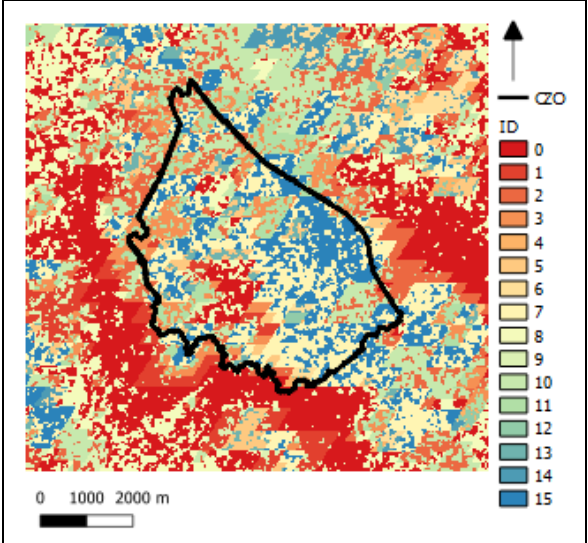
Figure 5.1. Threshold Value = 10